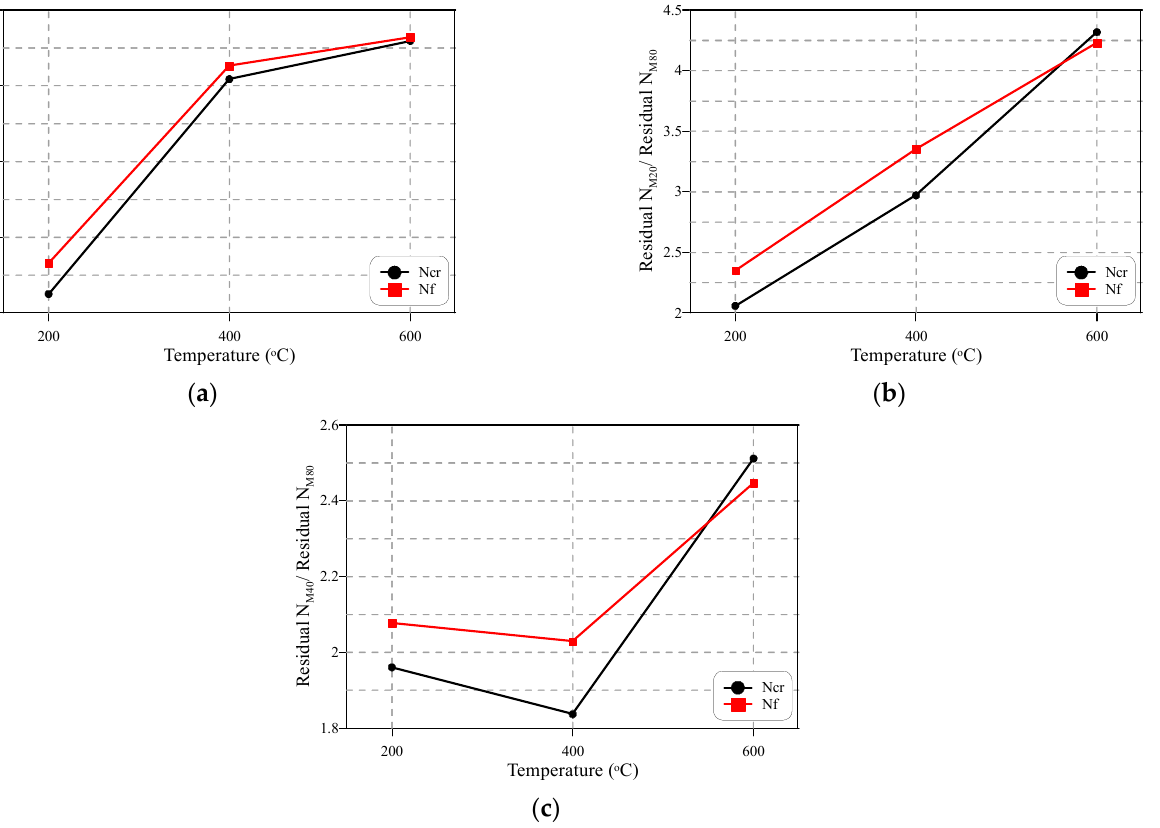
Figure 13. Effect of concrete strength on the degree of deterioration of impact resistance: ( a ) residual M20/M40, ( b ) residual M20/M80, ( c ) residual M40/M80.